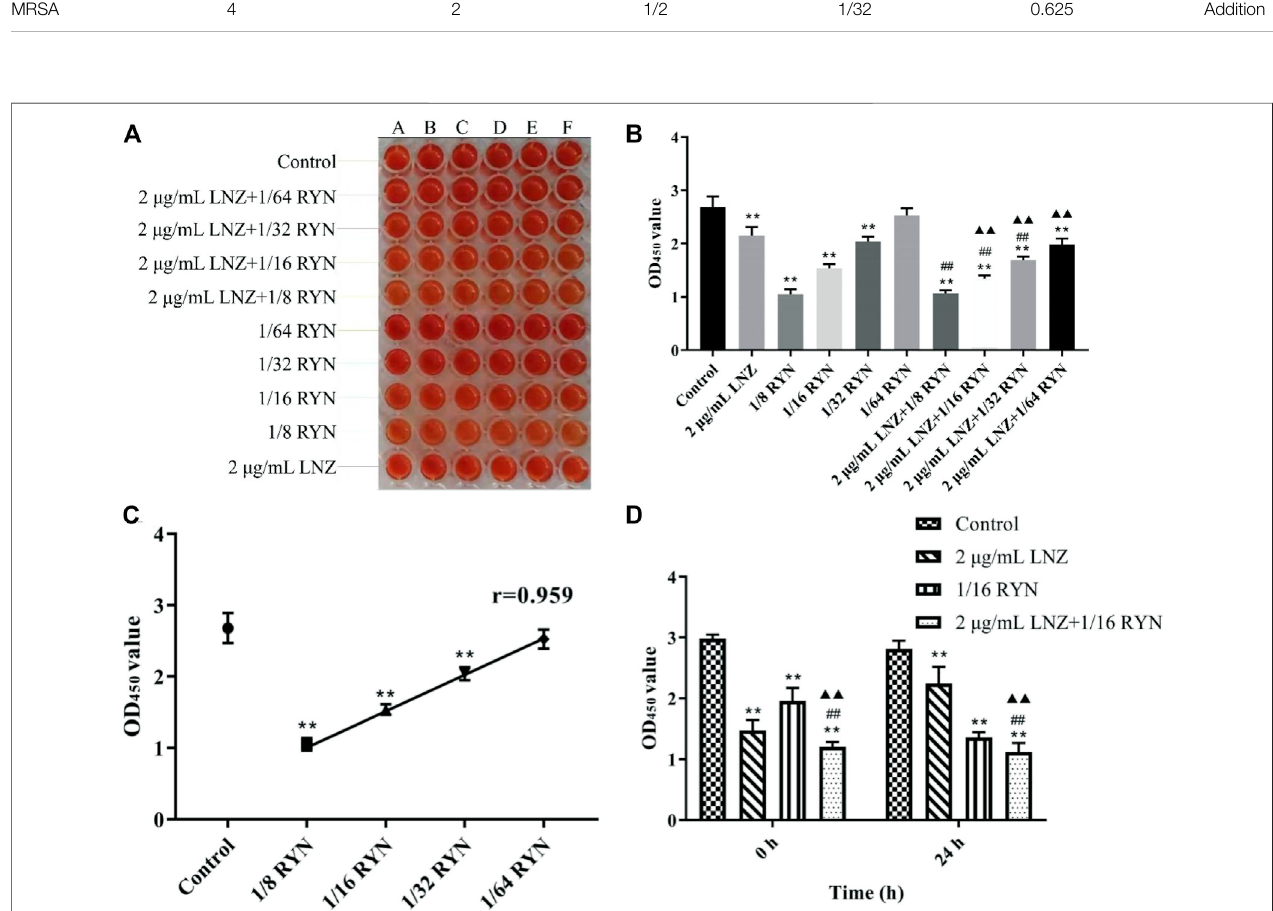
FIGURE 1 | Effects of single and combined use of LNZ and RYN on living bacteria before and after MRSA bio fi lm production. (** p < 0.01 vs. control group; ## p < 0.01 vs . 2 μ g/ml LNZ group; ▲▲ p < 0.01 vs . 1/16RYN group.). (A) Results of XTT staining; (B) The effects of single and pairwise use of LNZ of 1/2 MIC and four doses ofRYNonthenumber oflivingbacteriainMRSAbio fi lms; (C) TheeffectofRYNonthenumber oflivingbacteria inMRSAbio fi lmwasdose-dependent; (D) Before and after the formation of bio fi lms, the effect of 2 μ g/ml LNZ+1/16RYN was better than that of the two